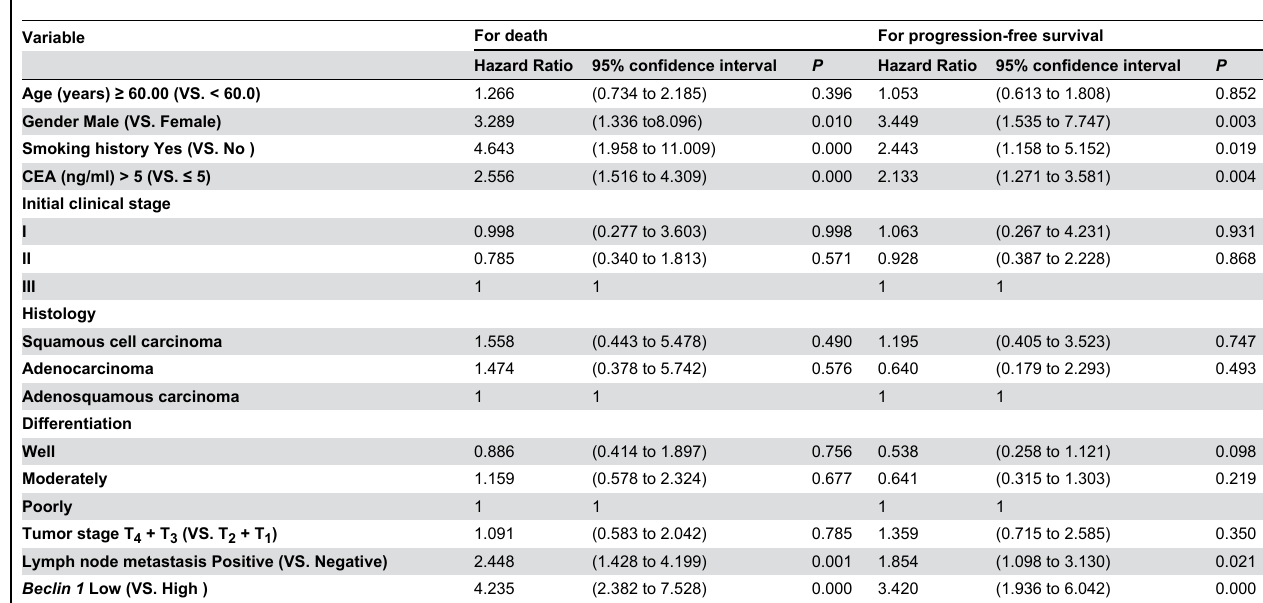
Table 2. Results of multivariate Cox proportional-hazards analysis in the testing set (n = 111).